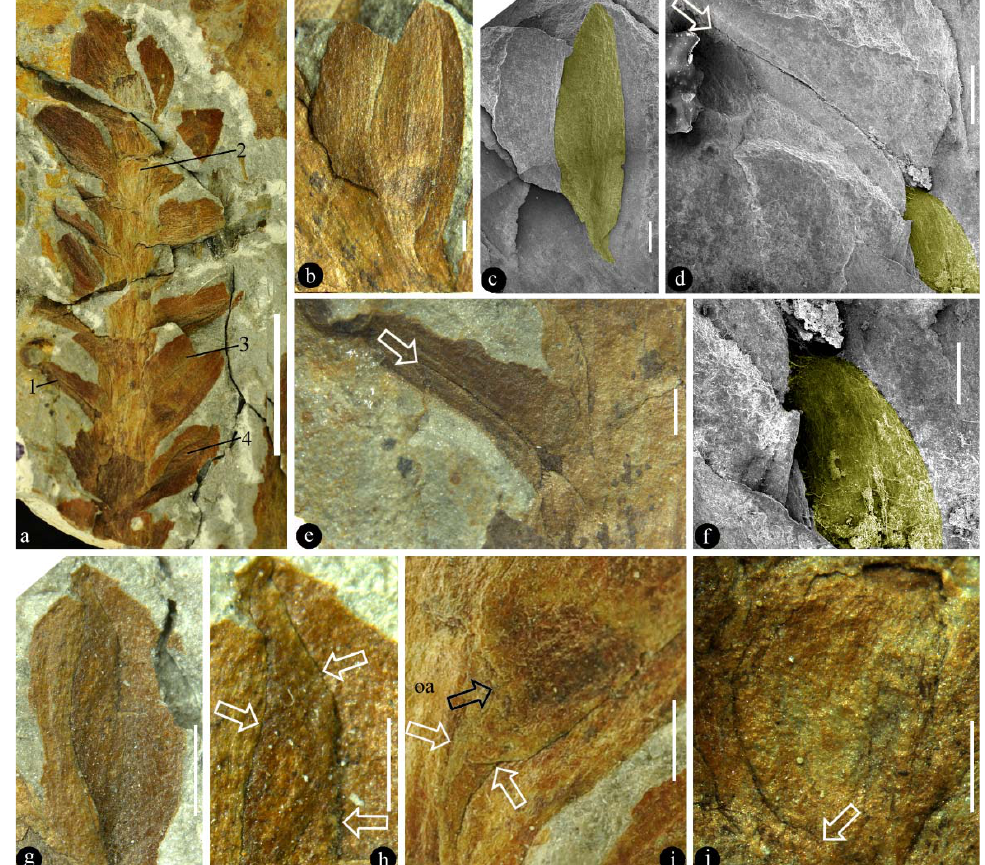
Figure 1. General view and details of the holotype of Combina gen. nov. specimen number MPZ2009-425. ( a ) The organ including multiple helically arranged lateral units. Scale bar = 10 mm. ( b ) Detailed view of the lateral unit 3 in ( a ). Scale bar = 1 mm. ( c ) The same as in ( b ), under SEM. The ovule is colored artificially. Scale bar = 1 mm. ( d ) SEM view of the lateral unit 1 in ( a ), showing the adaxial suture (arrow) of the bract. The ovule base is colored artificially. Scale bar = 1 mm. ( e ) View of the lateral unit 1 in ( a ), showing the adaxial suture (arrow) of the bract. Scale bar = 1 mm. ( f ) Detailed view of the basal portion of the ovule (artificially colored) that is eclipsed by the adaxial part of the bract, under SEM, enlarged from ( d ). Scale bar = 0.5 mm. ( g ) View of the lateral unit 4 in ( a ), showing the ovule “sandwiched” adaxially and abaxially by its bract. Scale bar = 2 mm. ( h ) Detailed view of the ovule (arrows), enlarged from ( g ). Scale bar = 1 mm. ( i ) Detailed view of the ovule base, enlarged from ( b ), showing its physical connection (funiculus, between white arrows) to the organ axis (oa). Note the asymmetrical connection (black arrow) between the funiculus and the ovule. Refer to Figure 3a. Scale bar = 1 mm. ( j ) Detailed view of the lateral unit 2 in ( a ), showing the asymmetrical connection (arrow) between the ovule and its funiculus. Refer to Figure 3b. Scale bar = 1